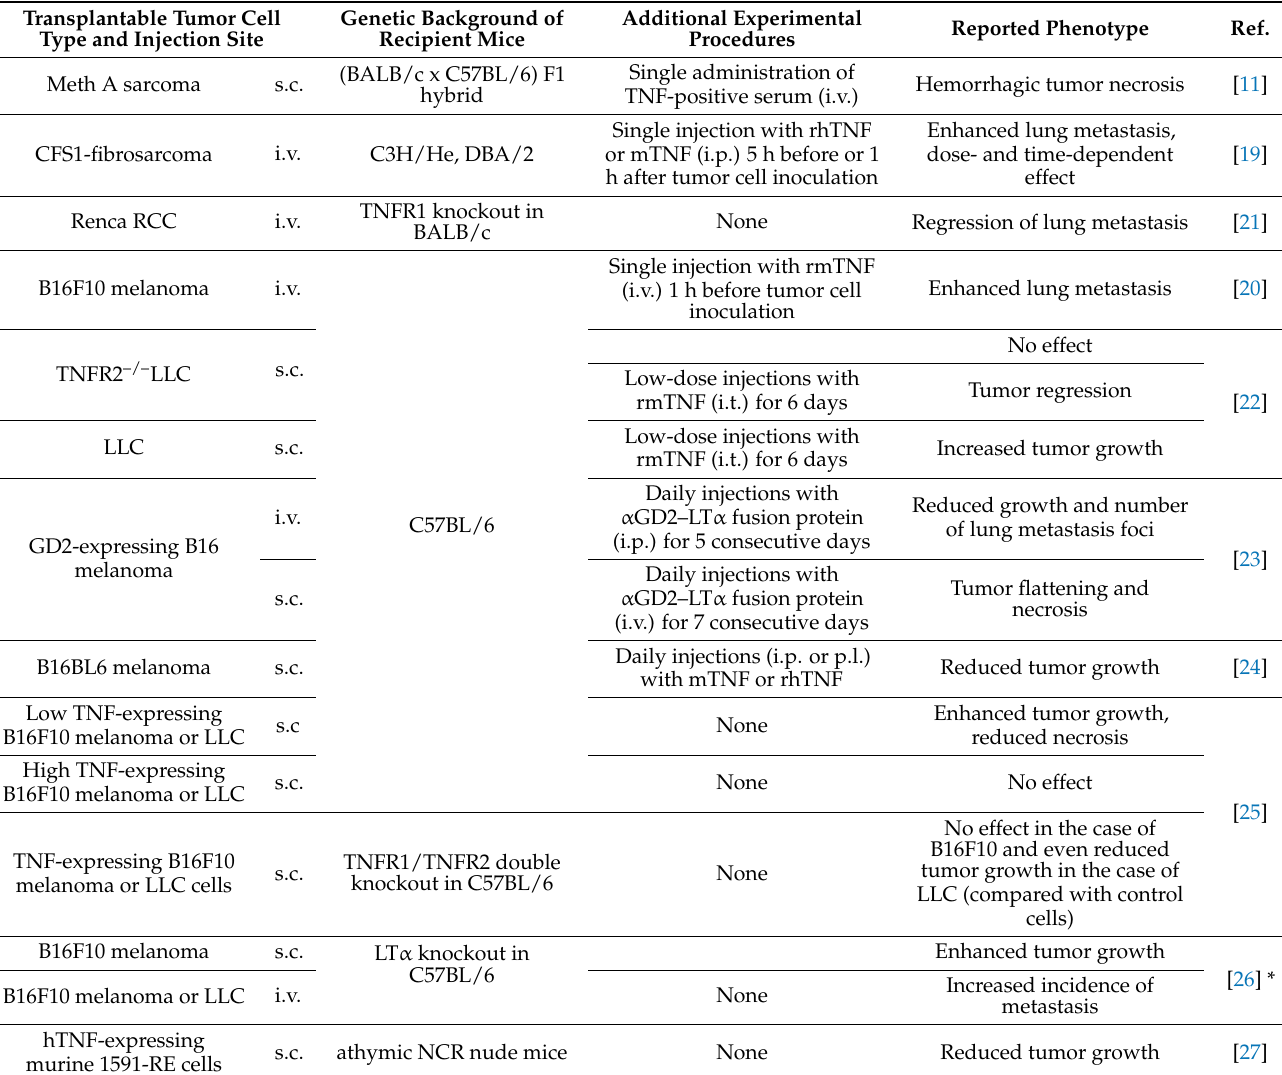
Table 1. Anti- and pro-tumorigenic effects of TNF and LT, as implicated by transplantable mouse tumor models. Transplantable Tumor Cell Genetic Background of Additional Experimental Reported Type and Injection Site Recipient Mice Procedures